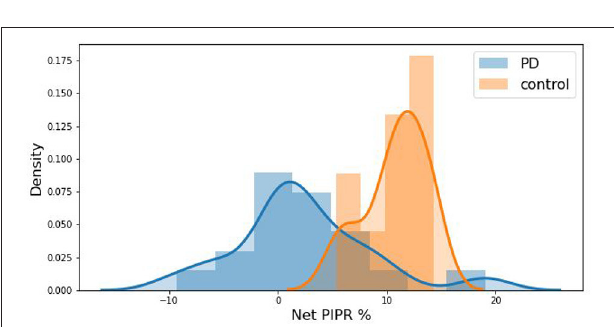
FIGURE 6 | Kernel density estimation curve depicting the distribution of subjects by Net PIPR Percentage indicating a difference between PD (blue) vs. Control